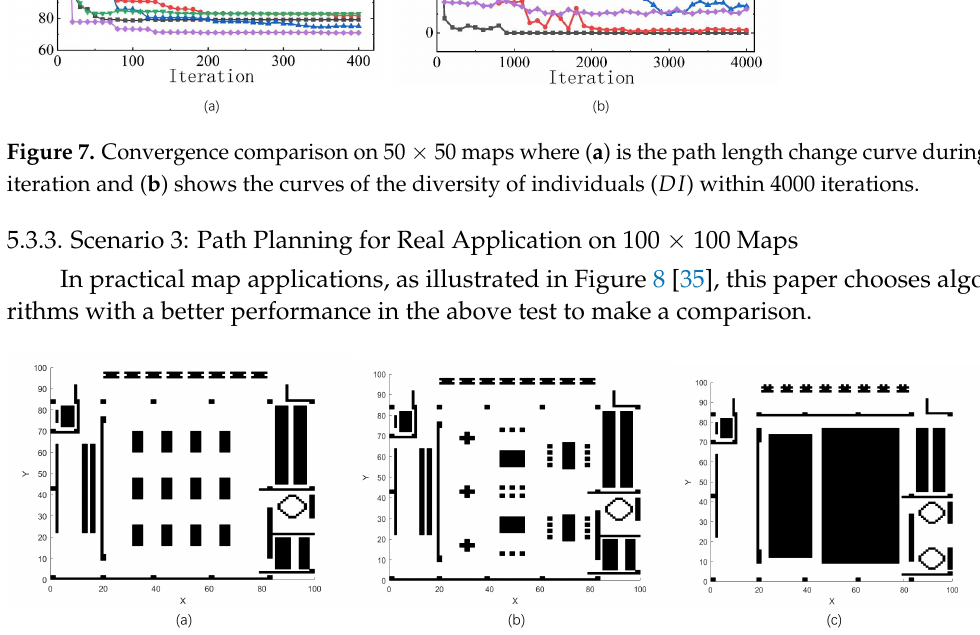
Figure 8. Real application on 100 × 100 maps of the Small Cultural Complex where ( a – c ) are the layouts corresponding to the function of the exhibition, sports, and performance,